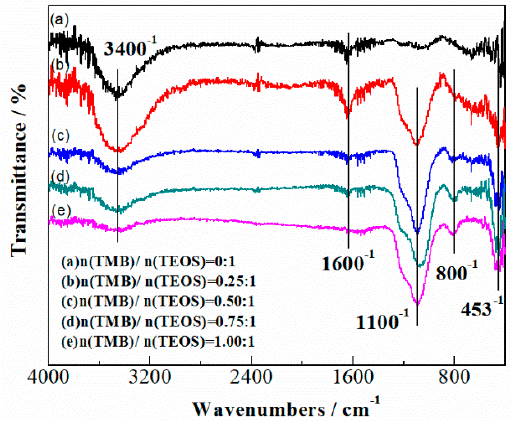
Figure 3. FTIR spectra of SiBCO aerogel with varying boron content.